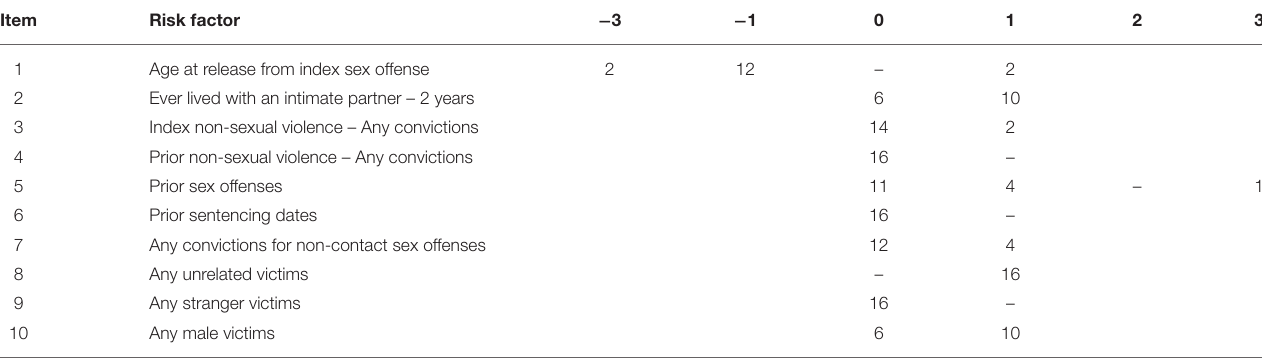
TABLE 2 | Risk assessment scores per item ( N = 16) on the STATIC 99-R. Item